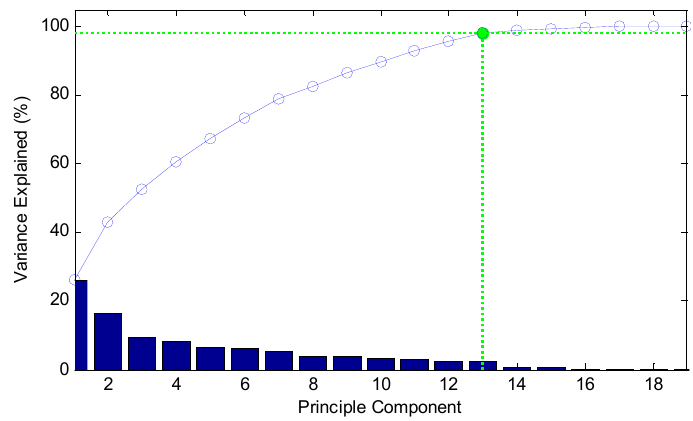
Figure 13. Cumulative sum of variance versus principle components.